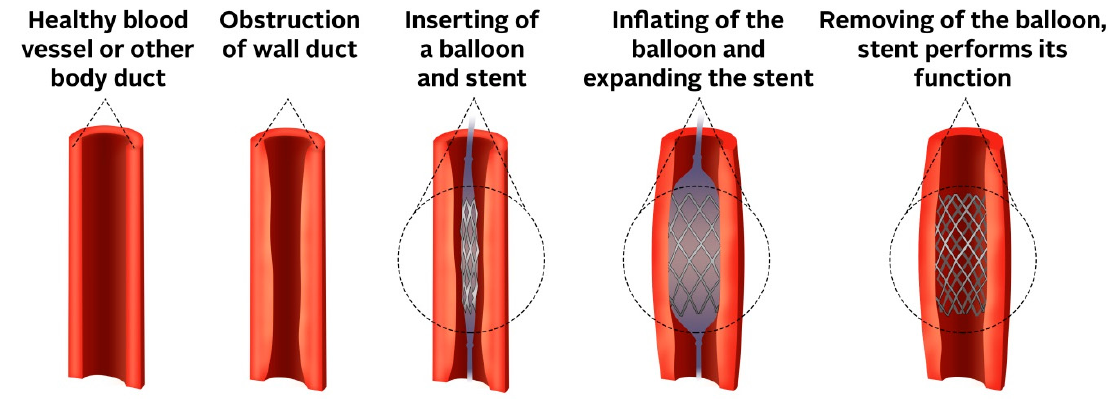
Figure 1. The principle of inserted stent.